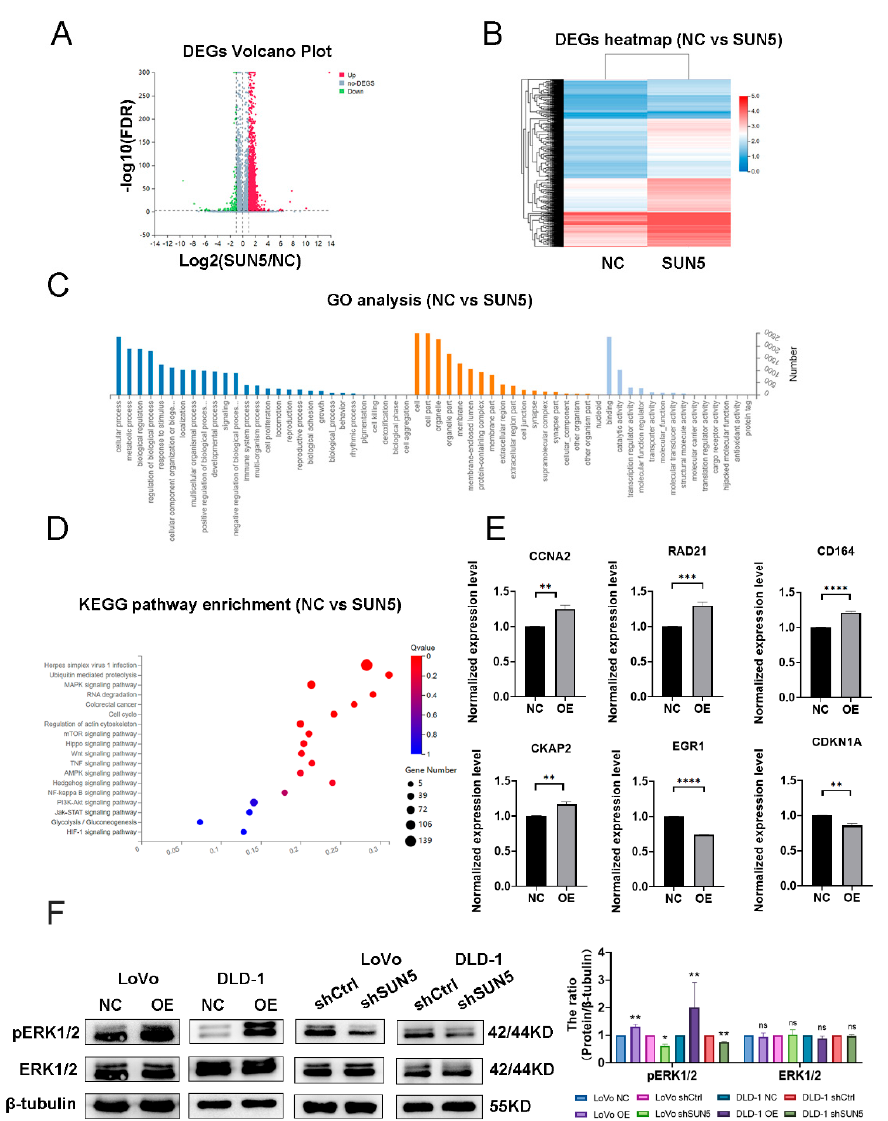
Figure 4. SUN5 regulated the level of phosphorylated ERK1/2 in colorectal cancer. ( A ) Scattered map of upregulated (red) and downregulated (green) genes positioned away from unchanged genes (gray). ( B ) Heatmap of DEGs comparing control and SUN5-OE group. ( C ) GO enrichment analysis